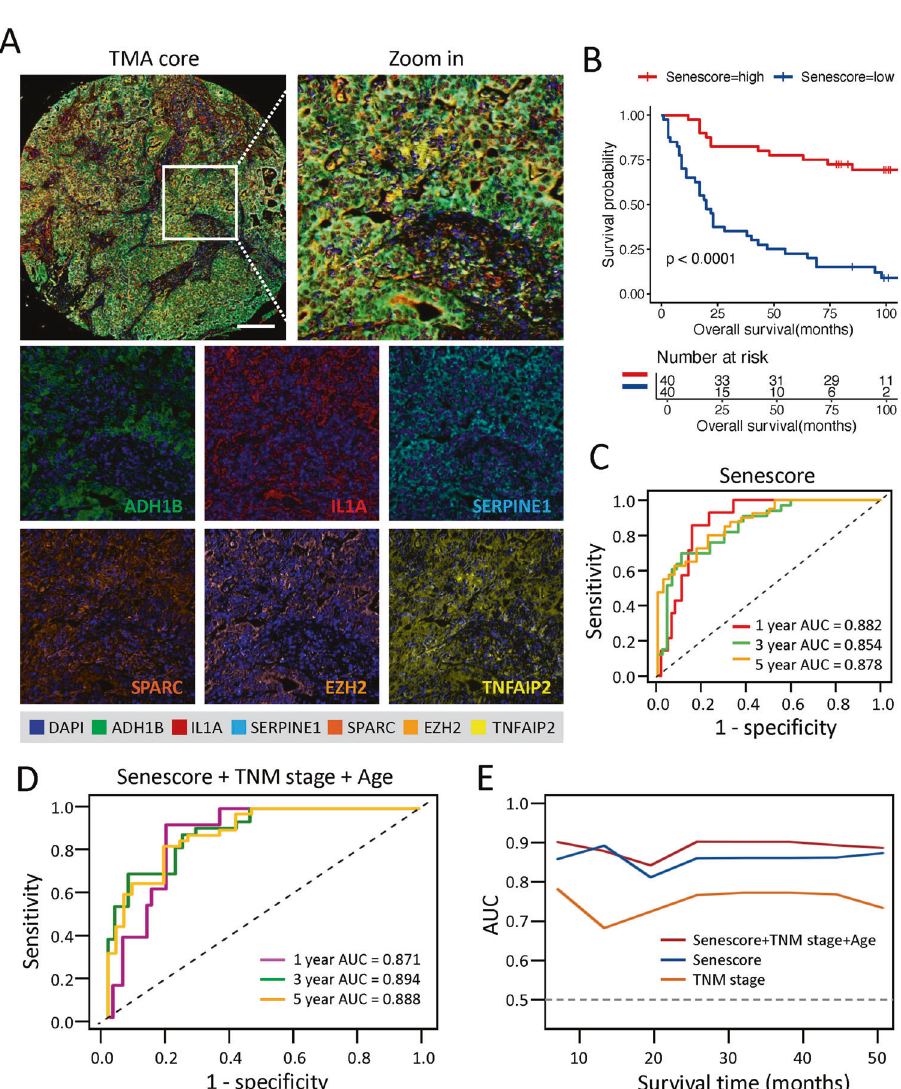
Fig. 7 Multiplex immuno fl uorescence immunohistochemistry pro fi ling of the senescore in tissue microarray of GC. A Representative multiplex immuno fl uorescence immunohistochemistry images showed the protein expression patterns of ADH1B (green), IL1A (red), SERPINE1(cyan), SPARC (orange), EZH2 (pink), and TNFAIP2 (yellow) in GC tissues. DAPI: blue; scale bar: 200 μ m. B Kaplan – Meier plot showed the signi fi cant difference of OS between high- and low-senescore groups in the tissue microarrays of GC. Log-rank test, p value was indicated. C ROC curve showed the predictive capability of senescore for overall survival of GC patients. D ROC curves of the senescore combined with clinical stage and age for predicting 1-year, 3-year, and 5-year survival. E Comparison of AUC of the time-dependent ROC curve among nomogram containing senescore, clinical stage and age, and only senescore or clinical